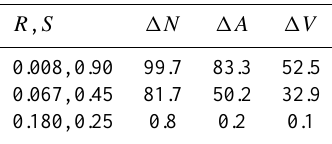
Table 1. Fractional contributions 1β(λ) (in %) to the total SAGE II spectral extinction (at λ = [0.386, 0.452, 0.525, 1.020]µm) of all particles smaller than 0.1µm in the case of three normalized (with number density N = 1 particle per cm 3 ) lognormal particle size distributions (background conditions with (a) median radius R = 0 . 008µm and distribution width S = 0 . 90; (b) R = 0 . 067µm, S = 0 . 45; (c) R = 0 . 180µm, S = 0 . 25) and how they compare to typical SAGE II experimental uncertainties, σ(β λ ) . The definition of the size distribution parameters N , R , and S is given in Sect. 2.